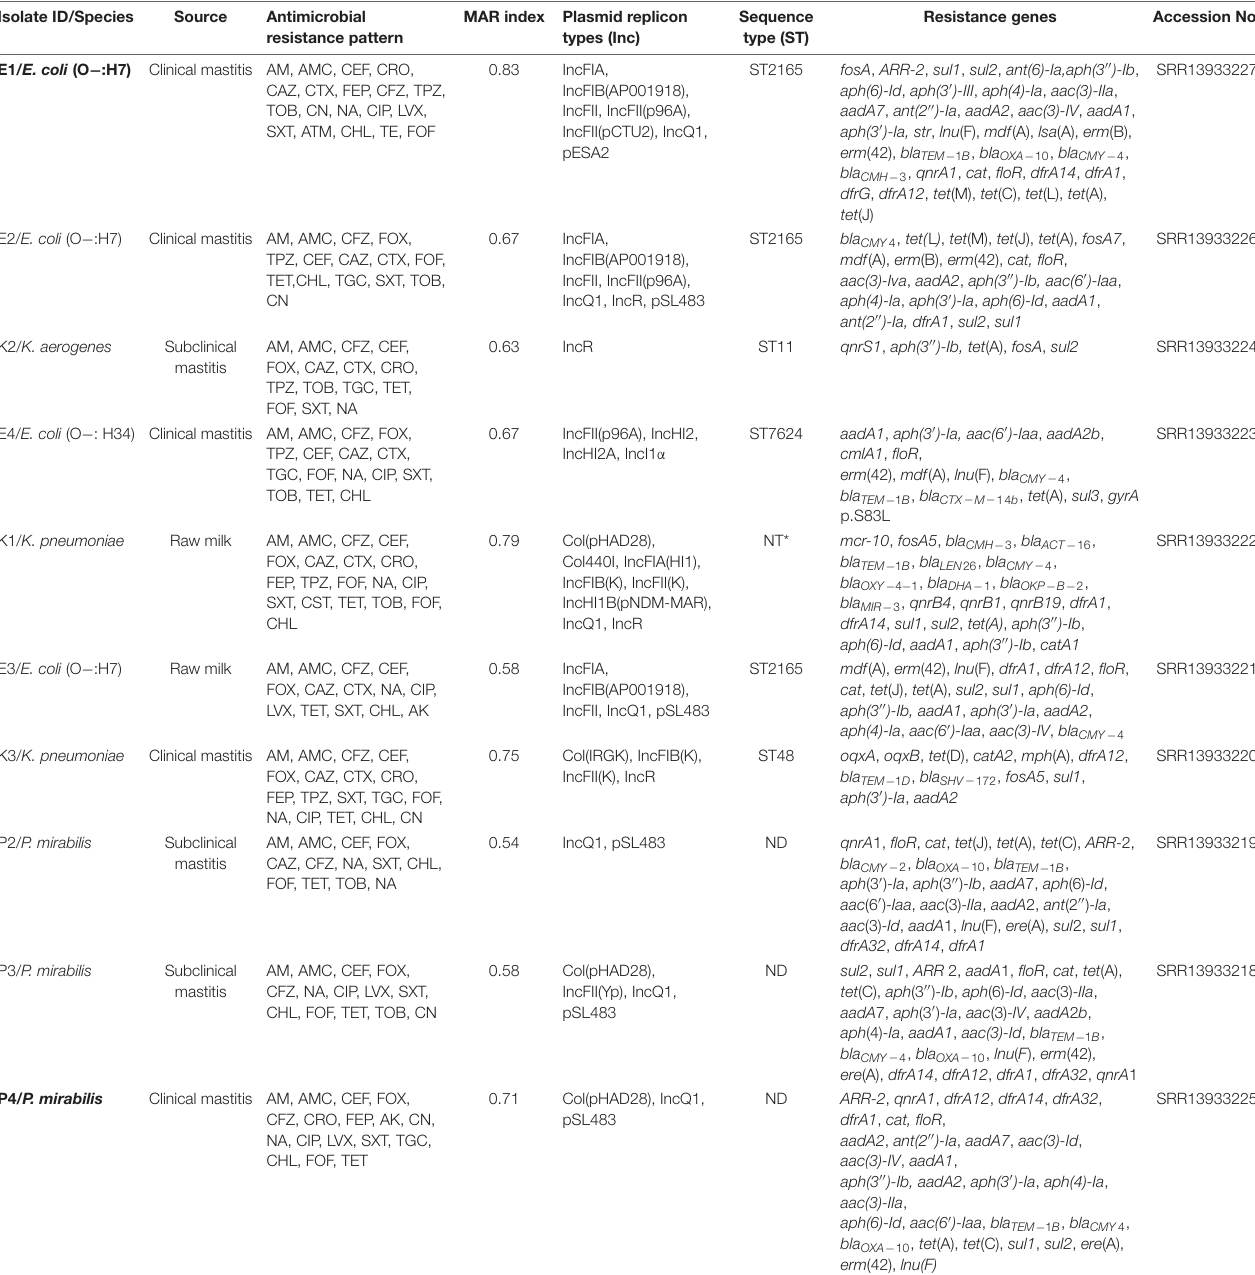
TABLE 2 | Molecular characteristics of MDR and XDR Gram-negative bacteria recovered from milk samples. Isolate ID/Species Source Antimicrobial